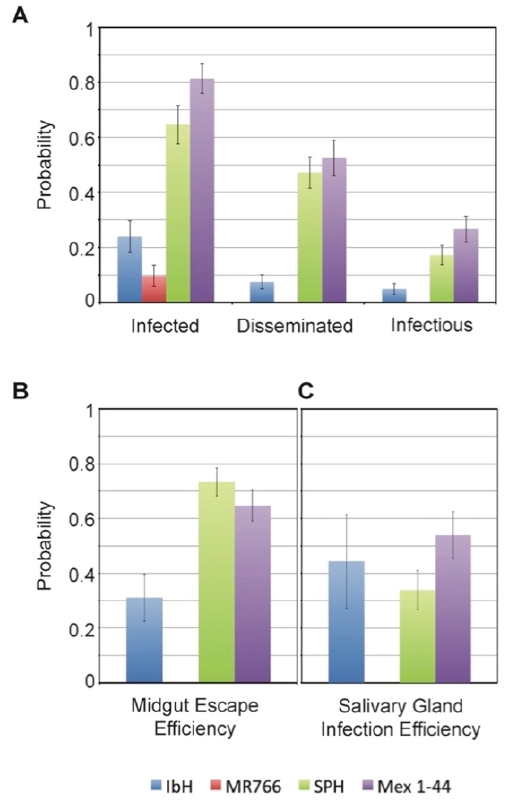
Figure 5. ZIKV dynamics in Aedes aegypti mosquitoes. Ae. aegypti mosquitoes were fed an infectious blood meal containing one the four ZIKV isolates (approximately 1.5 × 10 6 TCID 50 U/mL) and were maintained for 14–15 days before processing. ( A ) We determined the probability of mosquitoes becoming infected (ZIKV positive bodies compared to total number of engorged), having disseminated infections (ZIKV positive heads compared to total number engorged), and becoming potentially infectious (ZIKV positive saliva samples compared to total number engorged); ( B ) To examine the efficiency of the different ZIKV isolates to disseminate throughout the mosquito, we also compared the midgut escape efficiency (ZIKV positive heads compared to ZIKV positive bodies); ( C ) To compare the ability of the isolates to infect the salivary gland, we determined the salivary gland infection efficiency (ZIKV positive saliva compared to ZIKV positive heads). Statistics for the data are shown in Table 2. Table 2. Results from our mixed effects generalized linear models (binomial distribution; replicate = random factor) and Tukey honest significant difference (HSD) adjusted pair-wise comparisons.